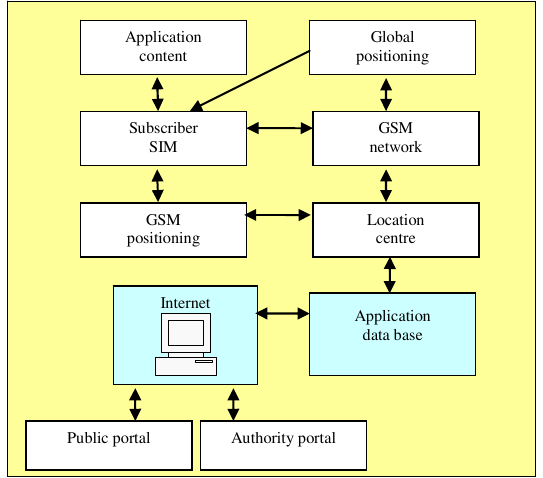
Fig 1. A system of positioning-based GSM